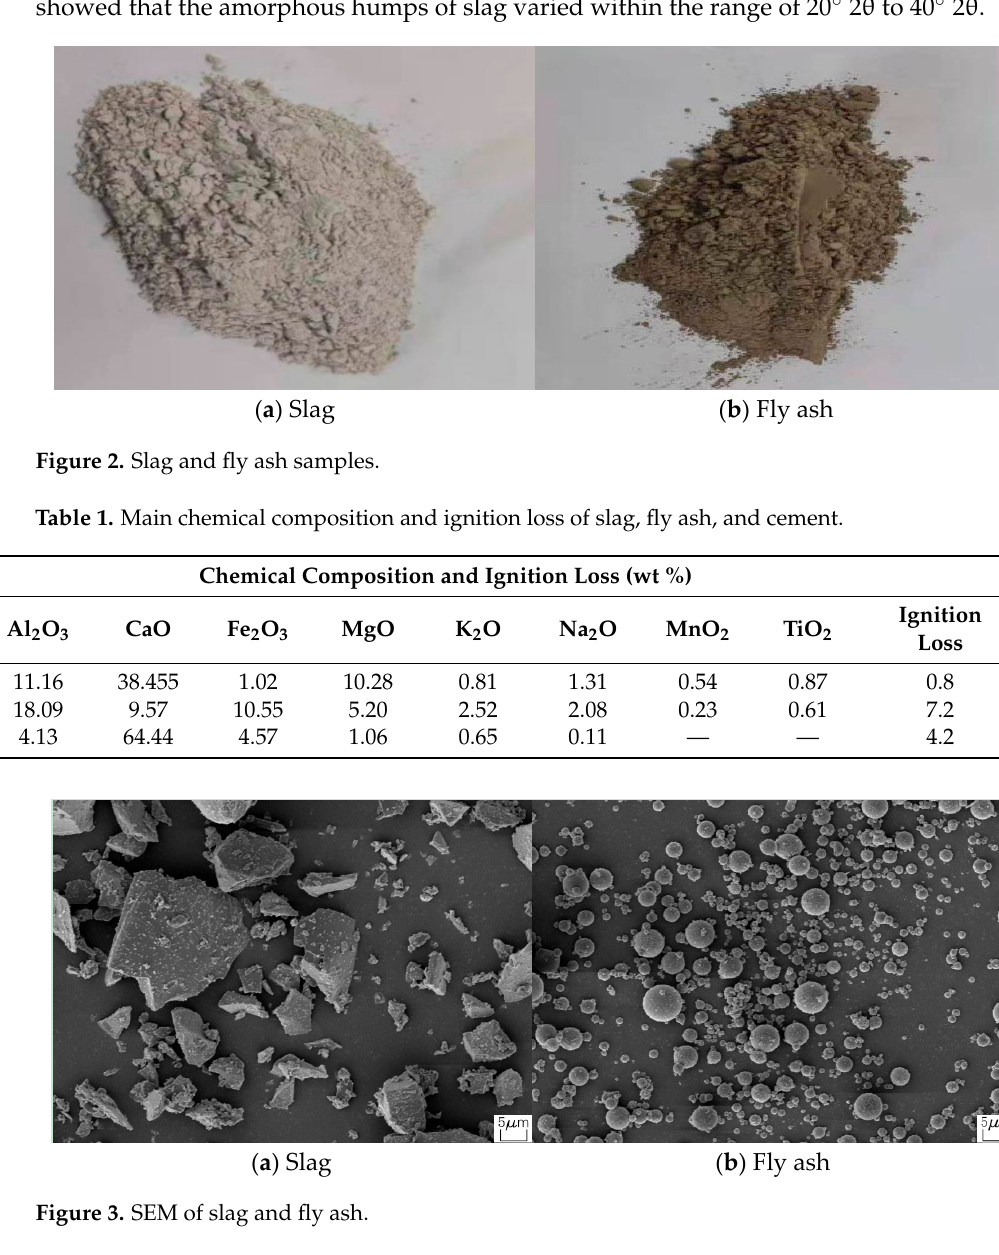
Figure 1. Particle grading curve.